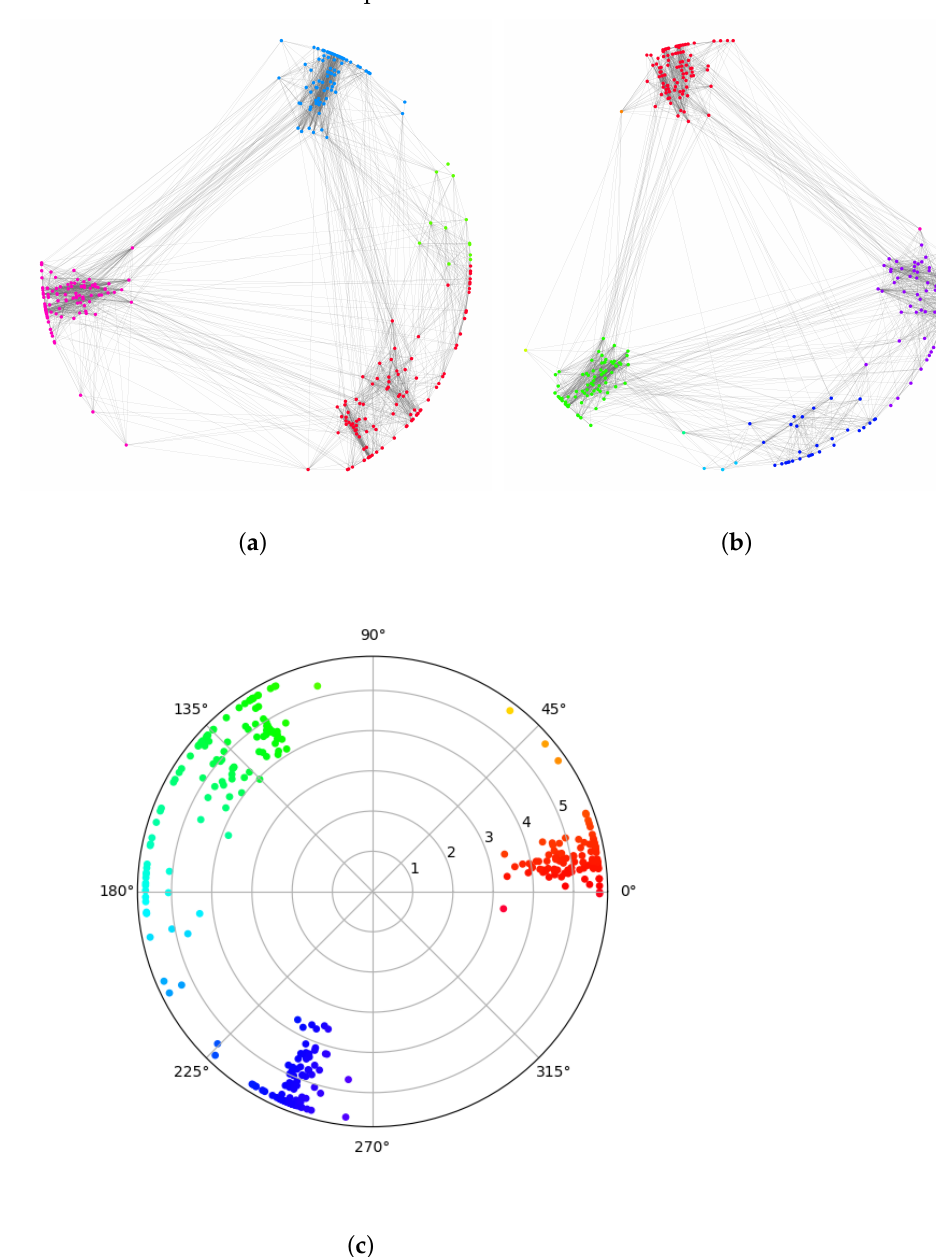
Figure 8. The community discovery visualization of the Students dataset based on hyperbolic embedding. ( a ) is the visualization of net0 in “Students” and ( b ) is the visualization of net1, we can see the evolution from net0 to net1. ( c ) shows the hyperbolic coordinates of the